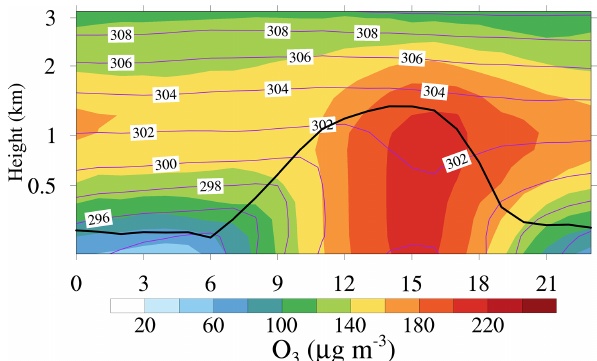
Figure 8. Temporal–vertical distribution of O 3 and potential tem- perature covering CZ, WX, SZ, SH, HZ1, JX and HZ over the in- nermost domain in